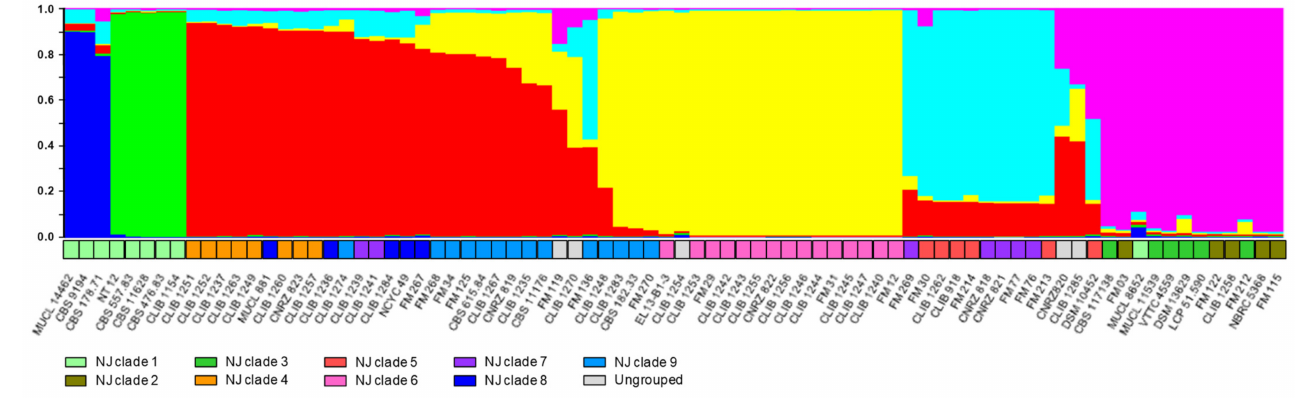
Figure 3. Analysis of microsatellite data and clustering of the G. candidum strains by “Instruct”. Colours of the histogram columns represent the proportion of the genetic constitution of an individual derived from each of the six hypothetical ancestral populations. For comparison with the analysis presented in Figure 1, the panel immediately above the isolates’ names shows the clades defined previously: light green, clade 1; khaki, clade 2; green, clade 3; orange, clade 4; red, clade 5; pink, clade 6; purple, clade 7; dark blue, clade 8; turquoise, clade 9; grey, strains not associated with named clades in the previous